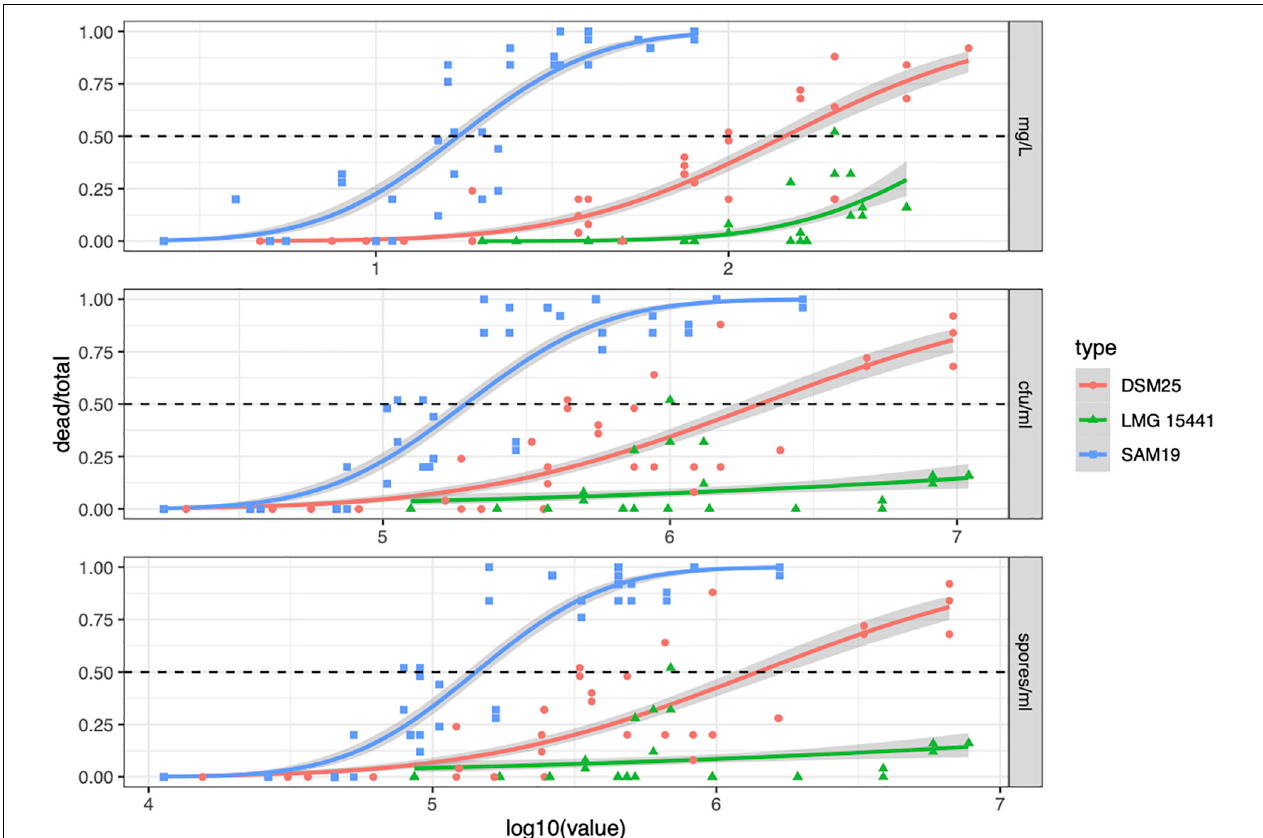
FIGURE 5 | Probit analysis of mortality data of Aedes albopictus larvae treated with Brevibacillus laterosporus strains SAM19, DSM25, and LMG 15441. The analysis was performed on data collected at 24 h after exposure to bacteria. The dead/total ratio is reported as a function of the concentration (log10) of each suspension expressed as mg/L (upper panel) , cfu/mL (middle panel) or spores/mL (lower panel)